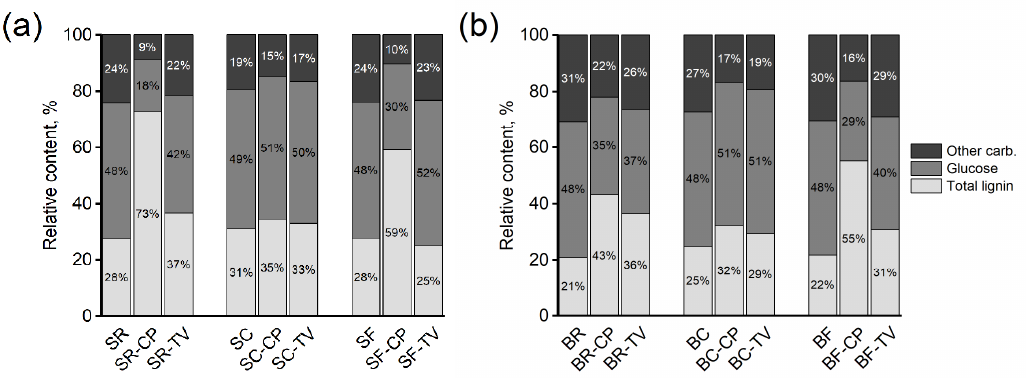
Figure 4. Relative content of total lignin (acid soluble + Klason), glucose and other carbohydrates in ( a ) spruce and ( b ) birch samples exposed to decay fungi C. puteana (CP) and T. versicolor (TV). Values are averages of duplicate analyses on pooled samples. R = unmodified; C = contact charred; F = flame charred; S = spruce; B = birch.